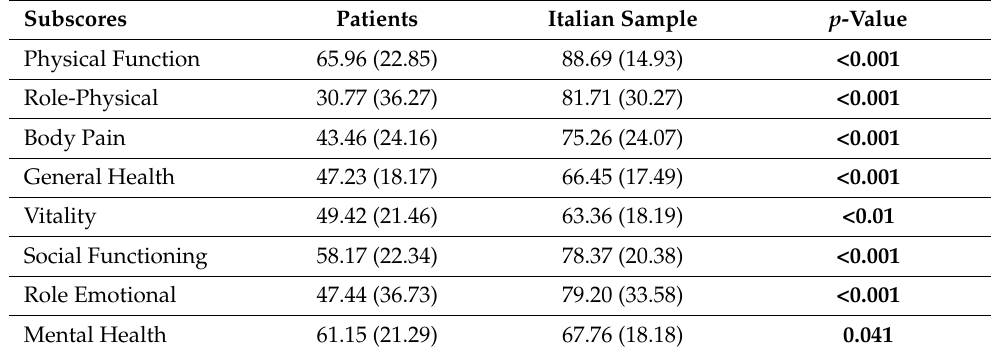
Table 6. Quality of life (SF-36): Comparison between patients and normative Italian sample at T0.